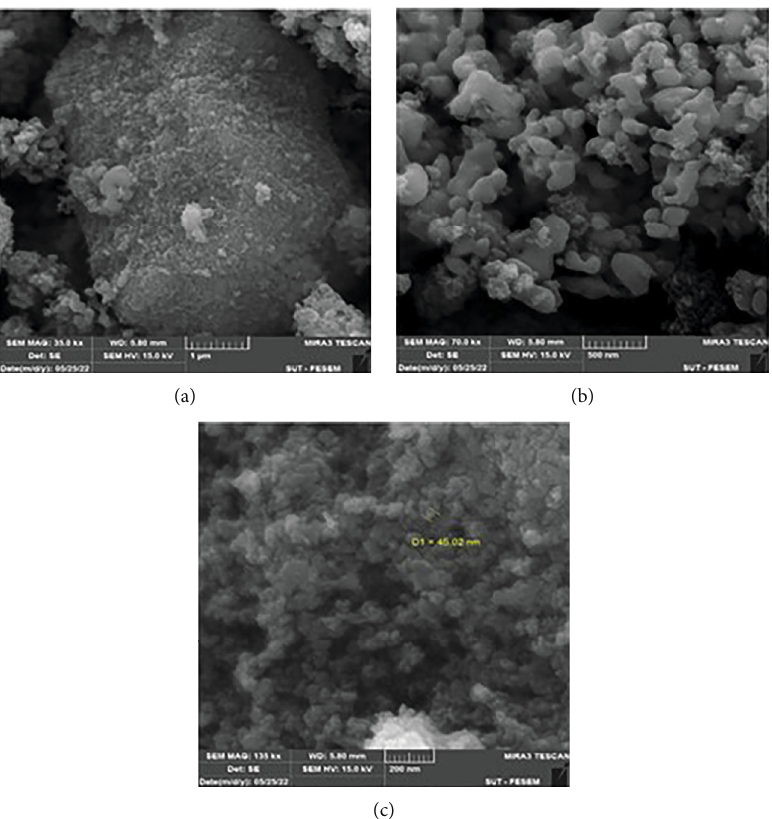
Figure 1: The alumina before packaging with di ff erent magni fi cations (a) with a magni fi cation of 1 μ m, (b) at a magni fi cation of 500nm, (c) at magni fi cation and of